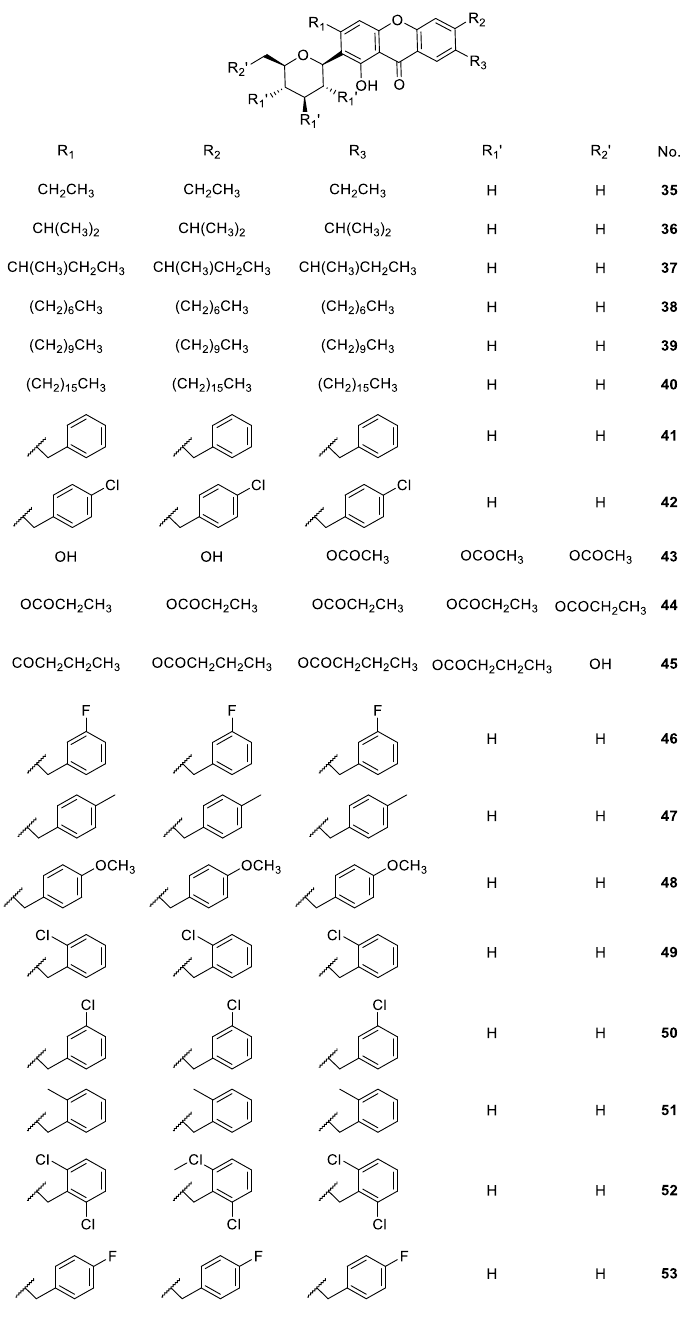
Figure 6. Structures of mangiferin derivatives 35 – 53 with antidiabetic activity.